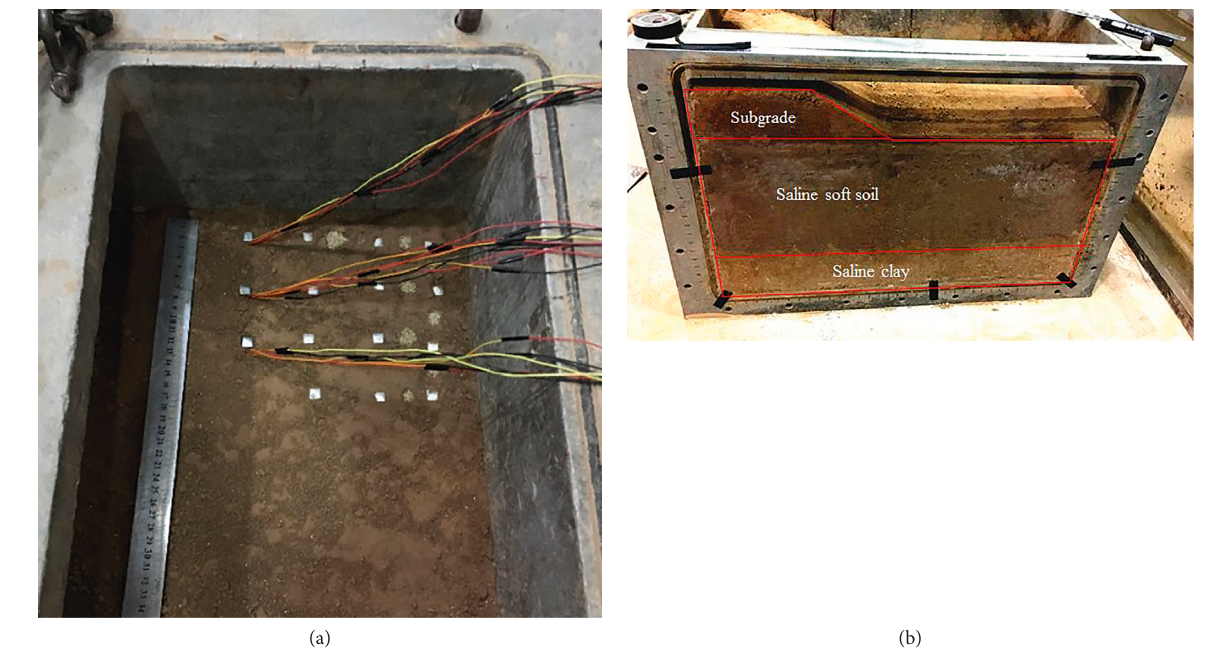
Figure 5: Composite foundation model. (a) Test model making process. (b) Model.